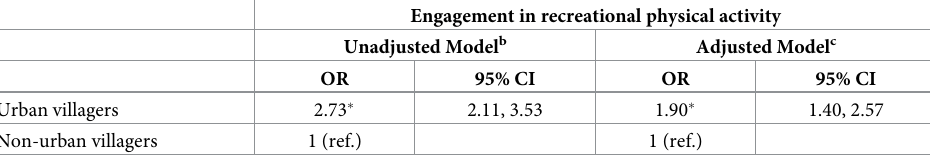
Table 2. Odd ratios of urban villagers and non-urban villagers in engaging in recreational physical